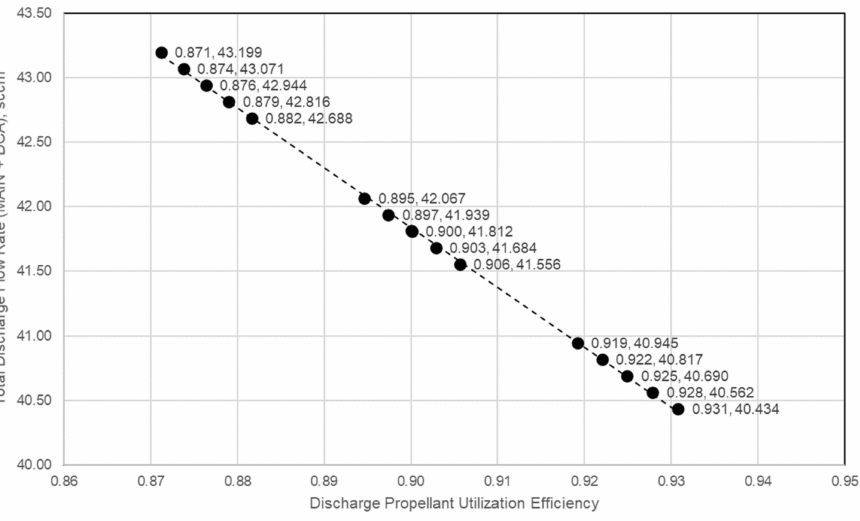
Figure 4. Flow rates and uncorrected mass utilization settings for evaluating NEXT over the range of potential DART operating conditions. The most “flooded” condition is at the upper left and corresponds to DTL28-A-A. The “nominal” condition is DTL28-H-H (0.900, 41.812), and most “lean” is DTL28-O-O (0.931, 40.434). Note that DTL28-H-H is equivalent to TL28 with respect to flow through the discharge